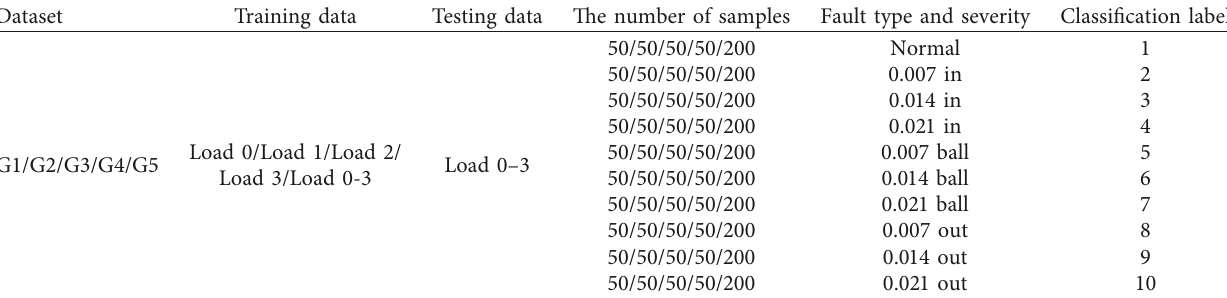
Table 4: Description of bearing datasets for multifault severity detection.